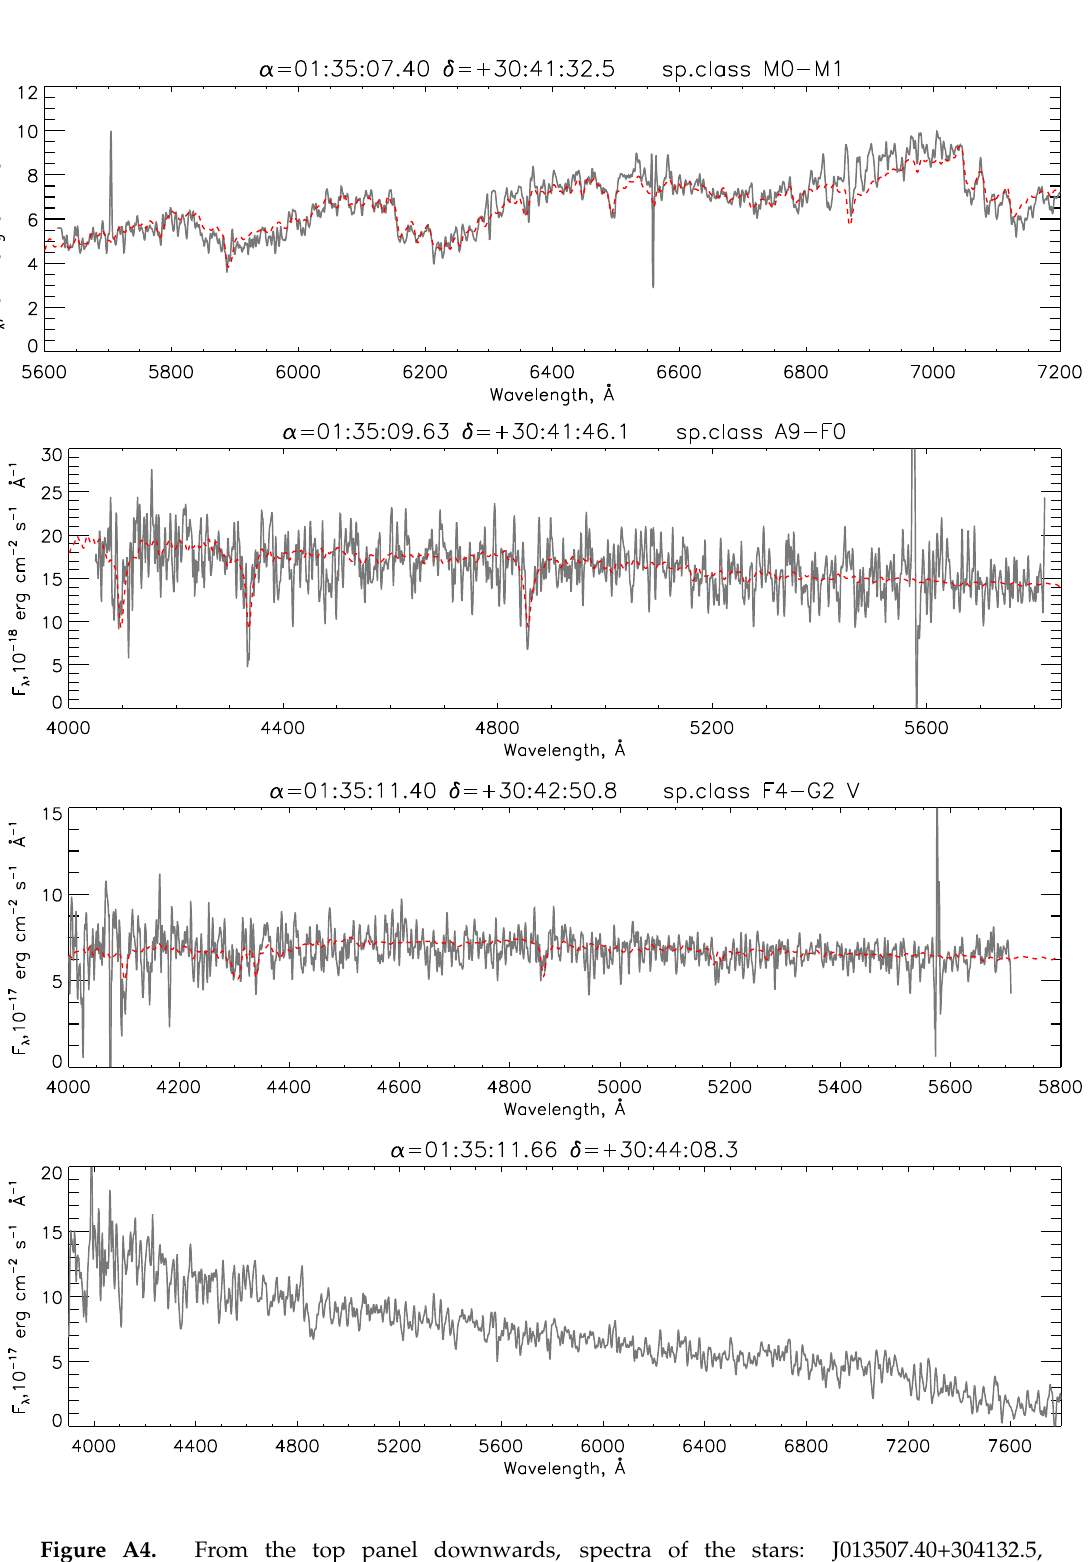
Figure A4. From the top panel downwards, spectra of the stars: J013507.40+304132.5, J013509.63+304146.1, J013511.40+304250.8 and J013511.66+304408.3. For comparison, the reddened spectra of HD146051 (M0.5III), HD50420 (A9III) and HD134169 (G1V) are shown by red dashed